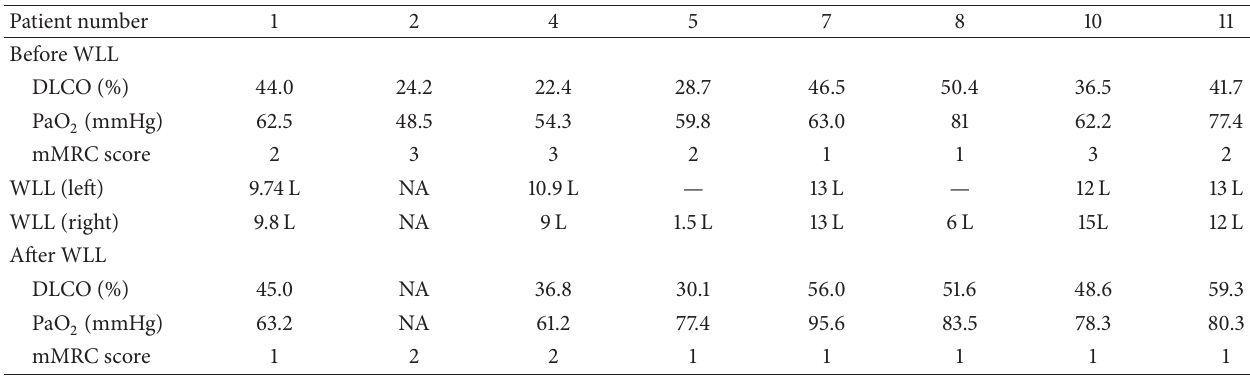
Table 3: Therapeutic evaluation of